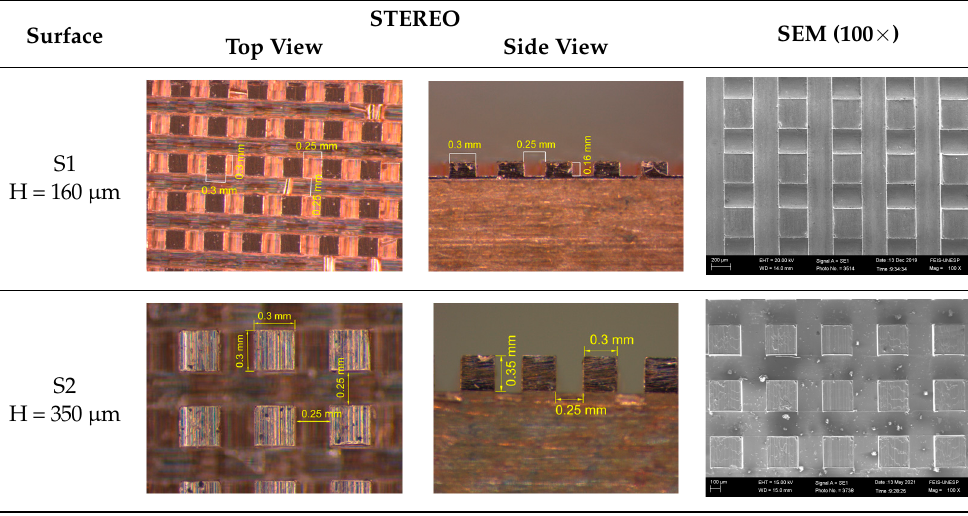
Table 1. Structural characterization of the micro pin fin heat sinks.